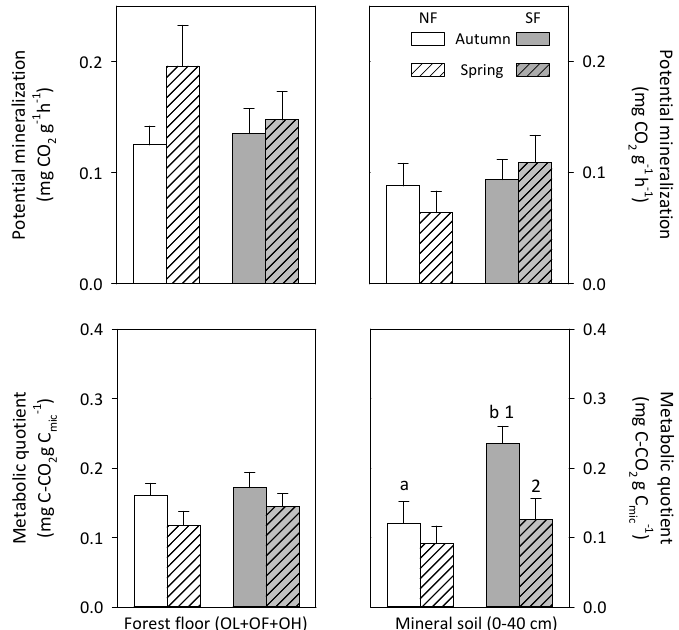
Figure 7. Potential mineralization (mg ∙ CO 2 ∙ g − 1 ∙ h − 1 ) and metabolic quotient (mg ∙ C ‐ CO 2 ∙ g ∙ Cmic − 1 ) in forest floor (OL + OF + OH) and mineral soil (0–40 cm) in a northern and a southern beech forest. Values are means ± standard = error; n = 36 for forest floor (6 sampling plots, 2 layers, 3 replicate analyses); n = 72 for mineral soil (6 sampling plots, 4 layers, 3 replicate analyses). Different lower ‐ case letters indicate significant differences between sites; differences between seasons are indicated by different numbers (two ‐ way ANOVA followed by post ‐ hoc Holm ‐ Šídák method; overall significance level = 0.05).